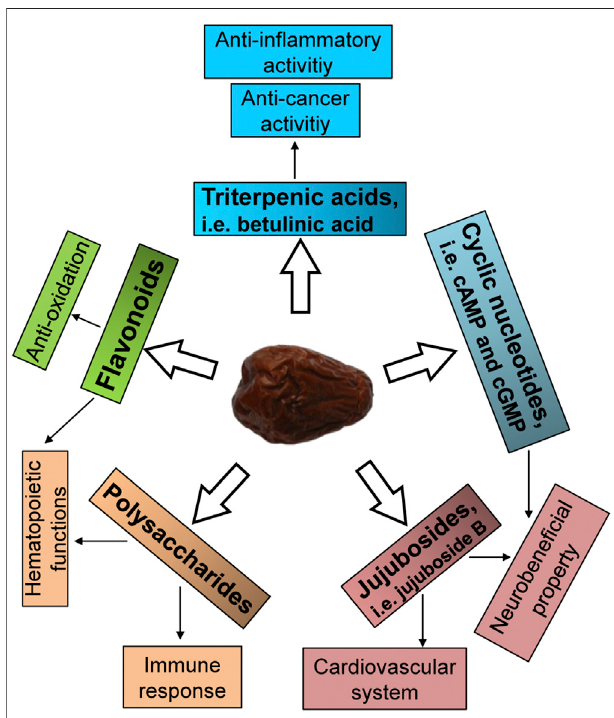
FIGURE 2 | Active ingredients of jujube. The potential active ingredients relating to the activities of jujube are summarized.